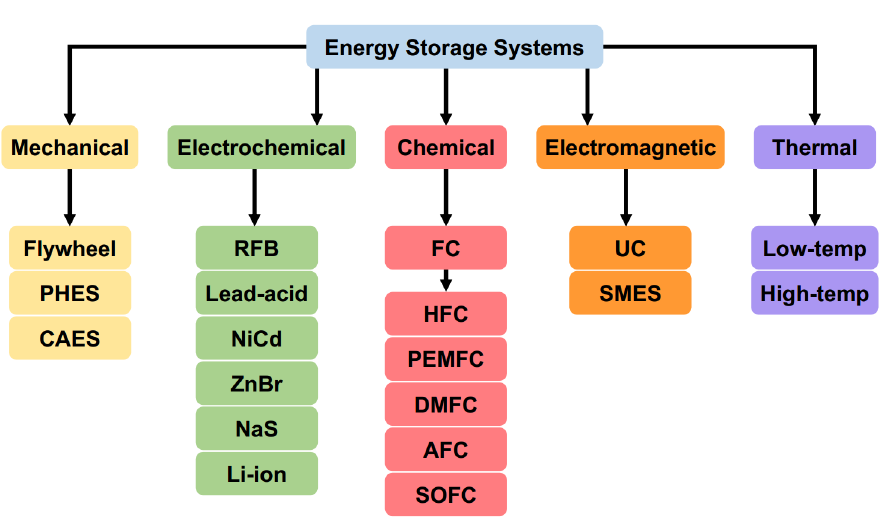
Figure 14. Classification of different ESS types